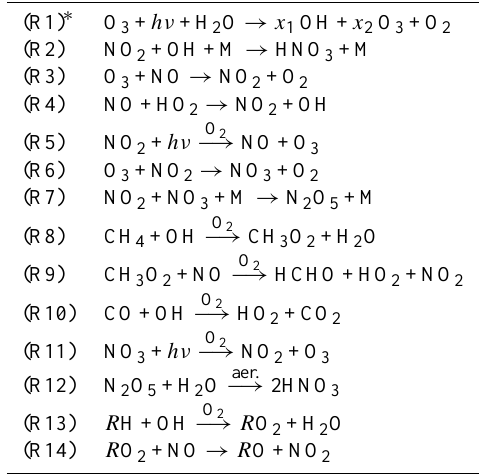
Table 1. Most critical O 3 /NO y /HO x reactions in PARANOX for both day and nighttime. We use R H as simplified notation for Volatile Organic Compounds (VOCs) ( R represents an organic